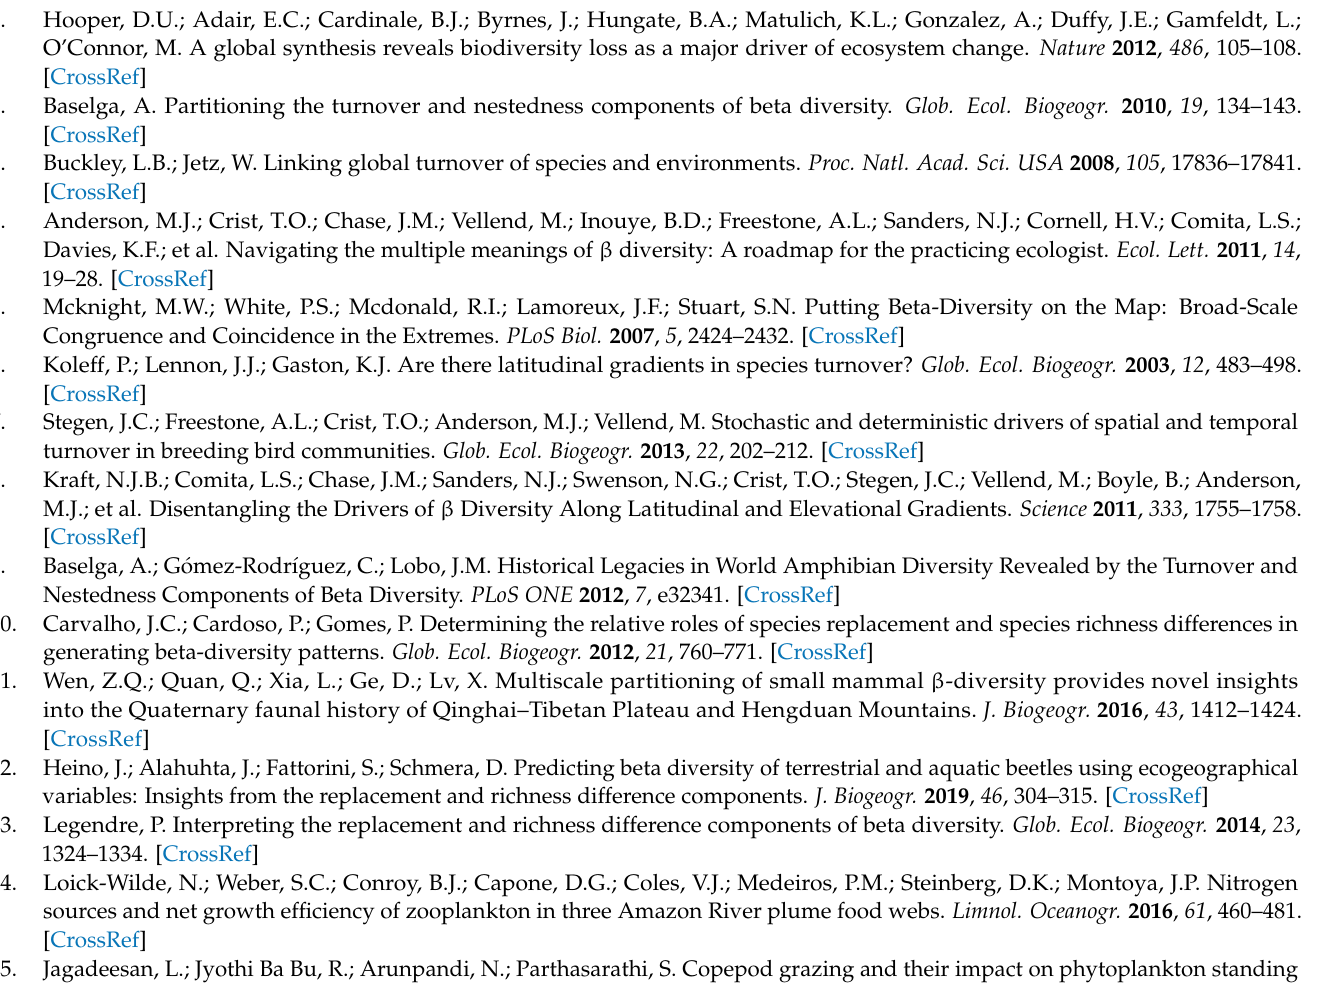
City; Table S4: Variations of environmental factors in the nutrient addition experiment; Table S5. The relative abundance of dominant zooplankton taxa in the different